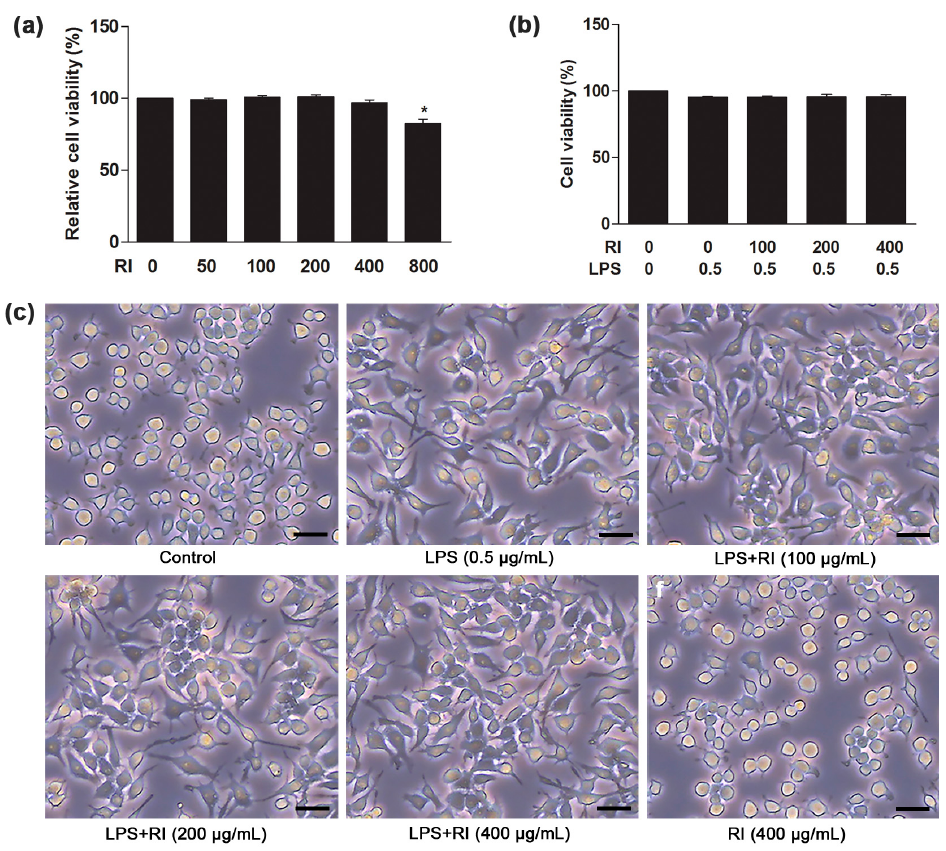
Figure 1. Protective role of Rabdosia inflexa (RI) on: ( a ) cytotoxicity; ( b ) cell viability; and ( c ) morphological alteration in RAW 264.7 cells were measured by MTT assay. Cells were pretreated with various concentration of RI (100, 200, and 400 µg/mL) for 1 h, followed by co-treatment with RI and LPS (0.5 µg/mL) for another 24 h. Cell morphology was visualized by optical microscopy (scale bar 200 µm). * p < 0.05 when compared with the control. Data are expressed as mean ± SEM of three independent experiments.